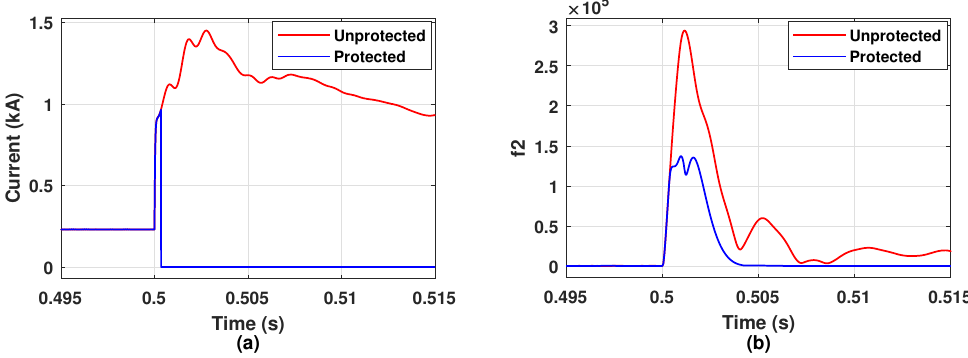
Figure 11. Interrupted and un-interrupted fault current comparison for a fault at F 1 having resistance of 1 Ω , ( a ) actual current and ( b ) feature f 2 .